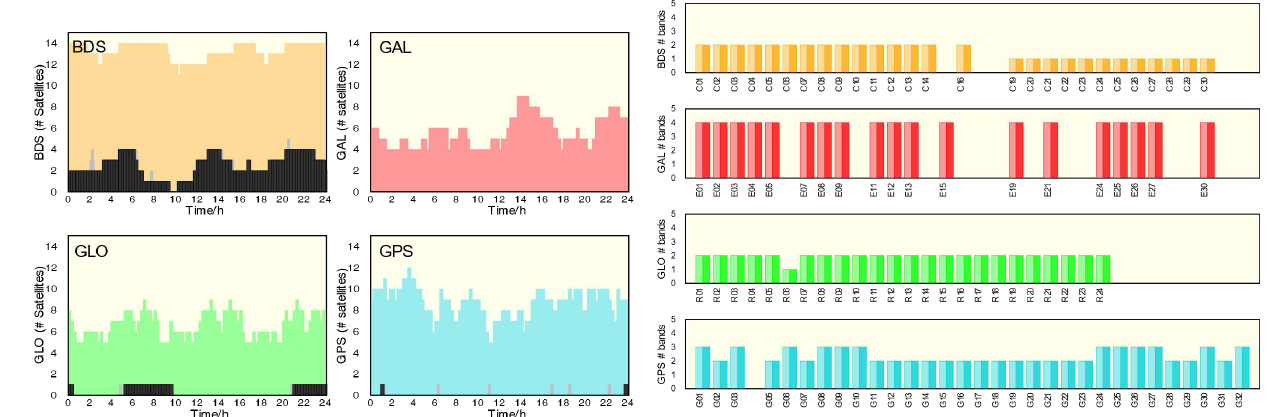
Figure 3. Satellite chart of each constellation